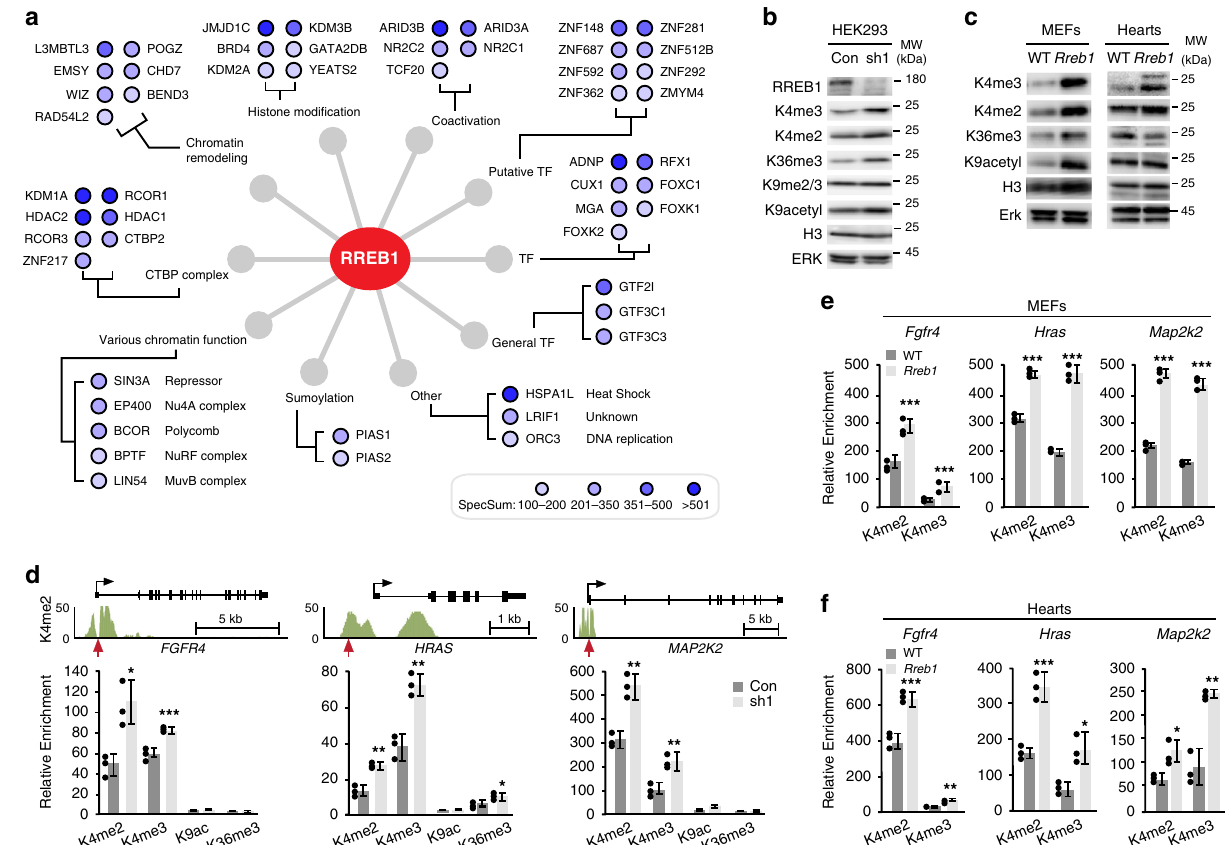
Fig. 5 RREB1-BioID reveals a mechanism of epigenetic histone regulation. a RREB1 interactors identi fi ed by BioID and classi fi ed according to information compiled at NCBI-Gene, Gene Cards, and literature searches. Dot color intensity represents spectral sum counts (SpecSum) as indicated in the scale. b Western blot analysis of histone modi fi cations in HEK293 cells expressing control shRNA (Con) or sh1- RREB1 (sh1)and c histone modi fi cations in WT and Rreb1 + / − MEFs and 6 month LV total lysates (Hearts). H3 and ERK are loading controls. All blots representative of n = 3 independent experiments. d ChIP analysis of H3K4me2 modi fi cation at the indicated promoters. Upper panels show the gene track view of H3K4me2 ChIP-seq (ENCODE, Broad Institute, K562 cells) at the FGFR4 , HRAS and MAP2K2 loci . Red arrows point to the RRE. Lower graphs show ChIP-PCR of the indicated histone marks at promoters from HEK293 cells expressing sh-control (Con) or sh1- RREB1 (sh1, n = 3). e ChIP analysis of histone modi fi cations at the indicated promoters in WT and Rreb1 + / − MEFs and (f) WT and Rreb1 + / − 6 month hearts ( n = 3; * p < 0.01, ** p < 0.001, *** p < 0.0001 two-tailed student ’ s t -test). For panels d , e , f error bars presented as mean values± SD. Source data are provided as a Source Data fi H3K4me3, K4me2, K36me3 and K9ac in lysates derived from sh1- RREB1 and Rreb1 + / − MEFs compared to control cells